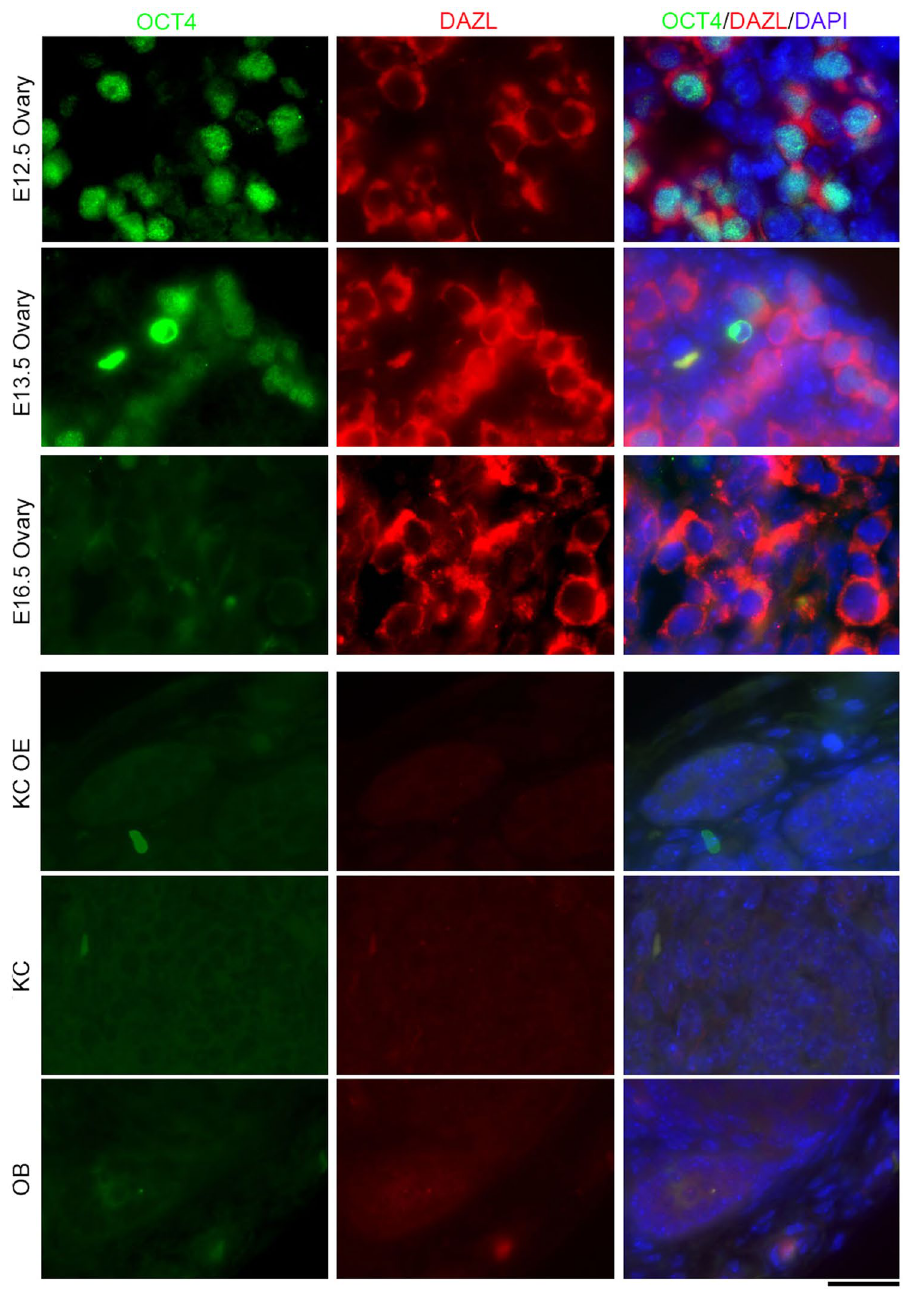
Figure 4. Presumptive germline stem cells (GSCs) are found in fetal ovaries but not in grafts 28 days after transplantation of PGCs-aggregates. Co-immunostaining and fluorescence of nuclear OCT4 and germ cell marker cytoplasmic DAZL in E12.5, E13.5 and E16.5 fetal ovaries (upper), and in grafts (bottom) 28 days following transplantation by different methods (Kidney capsule with ovariectomized, Kidney capsule and ovarian bursa). Scale bar = 20 μ